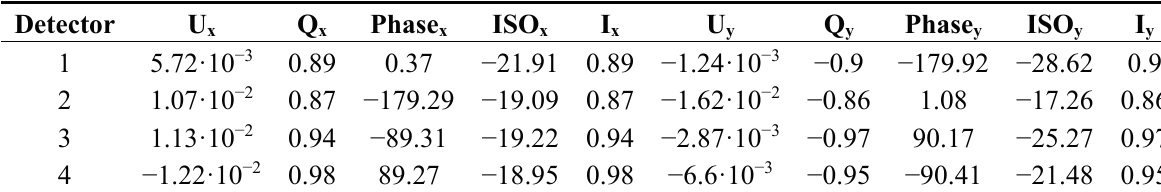
Table 4. Parameters calculated by using only the states numbered from 12 to 15 in Table 2 (Phase in Deg. and ISO in dB).